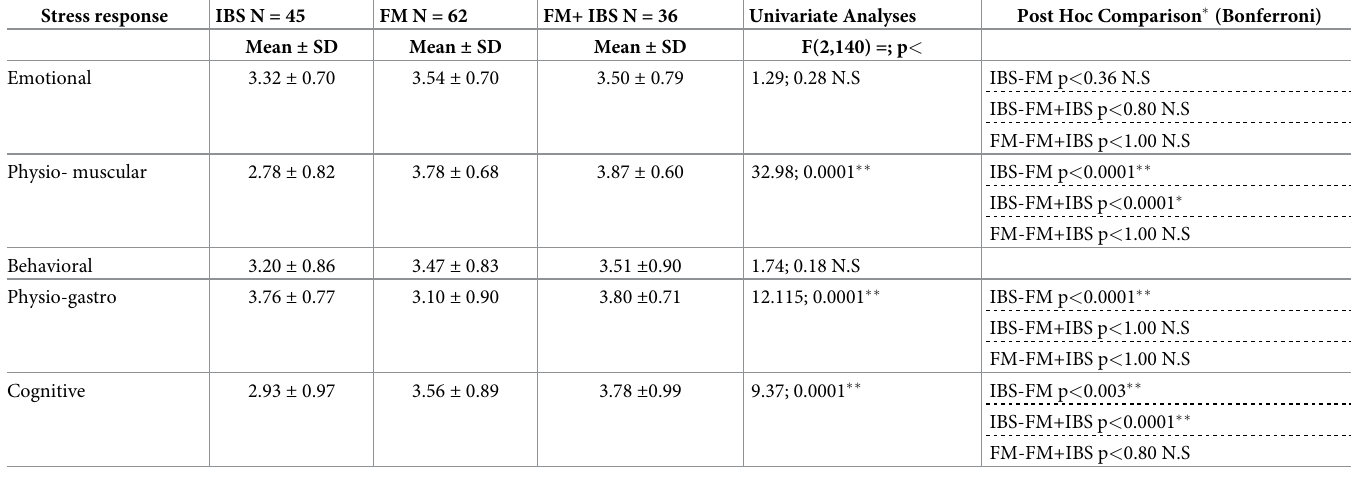
Table 3. Comparisons of stress responses between the study groups (study